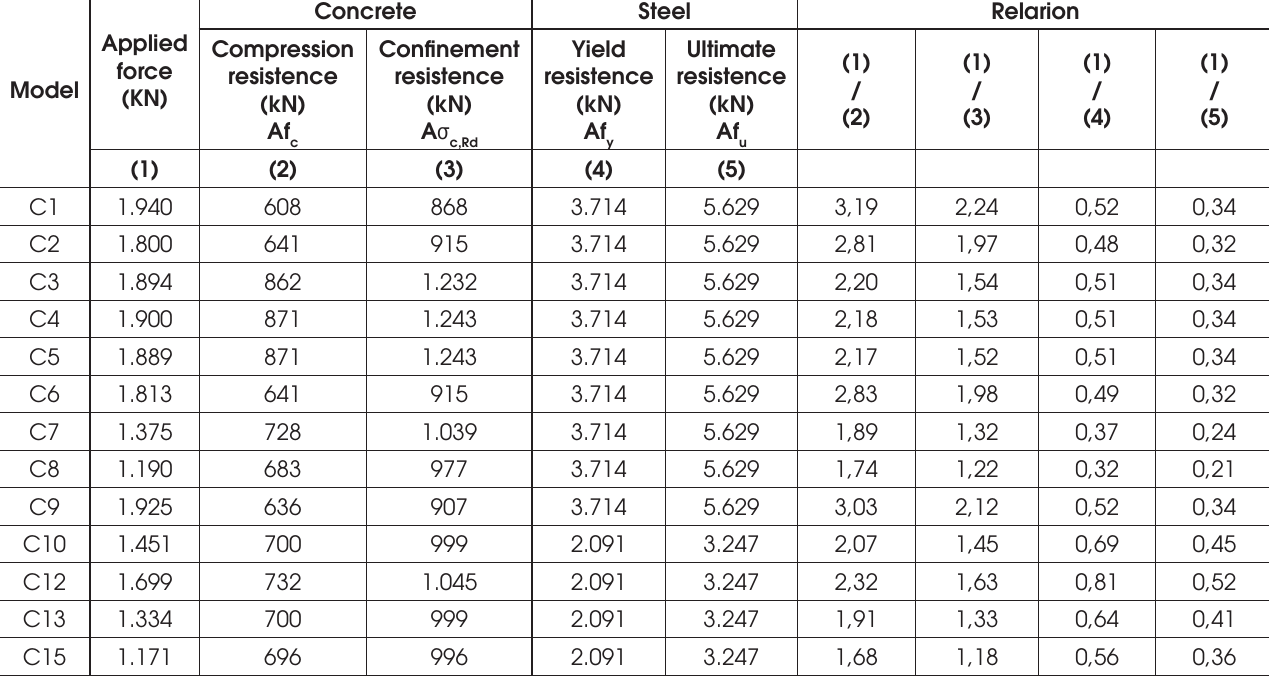
Comparison between applied force and resistant capabilities of steel and concrete